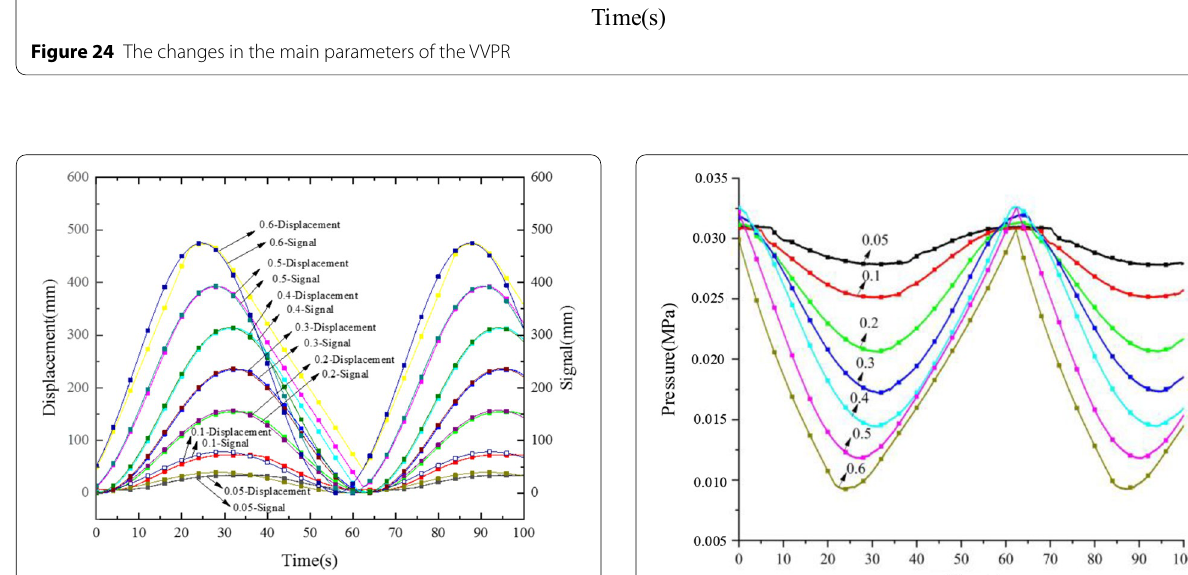
Figure 25 Hydraulic cylinder displacement curve